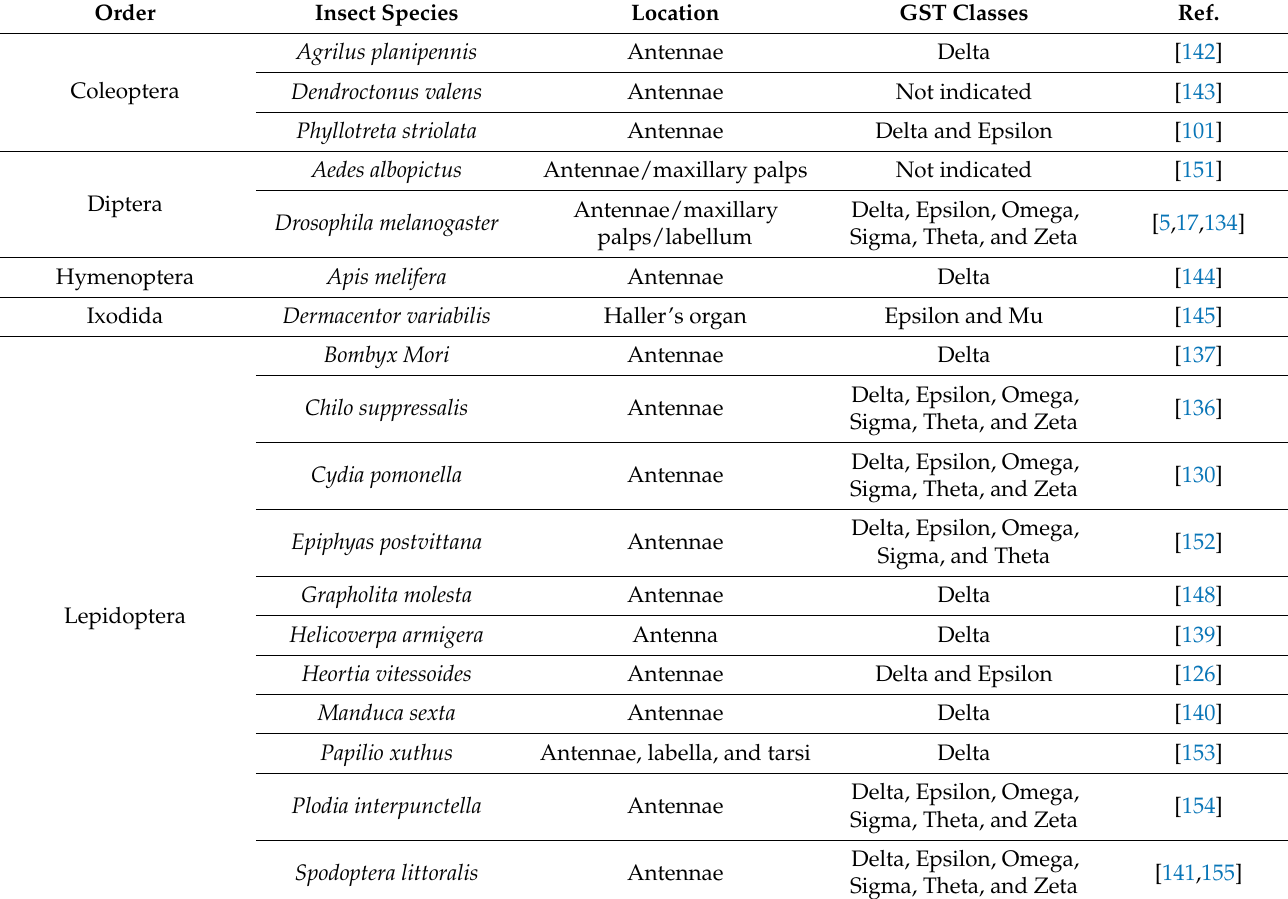
Table 3. Identification of GSTs in the chemosensory organs of various insect